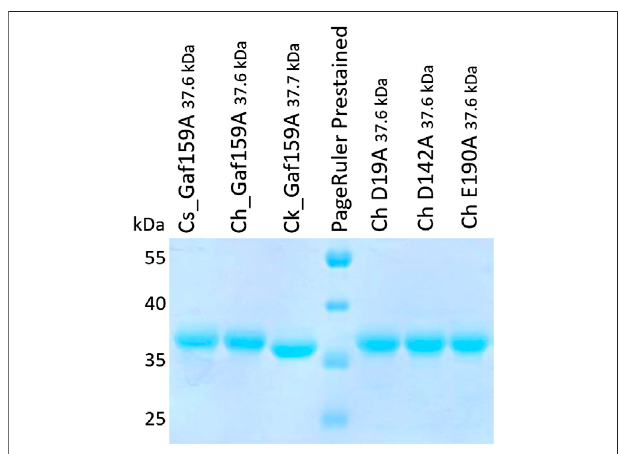
FIGURE 1 | SDS-PAGE analysis of recombinantly produced wildtype and mutant enzymes. Proteinsamples (0.5 µg μ l − 1 ) were mixed with 4x SDS- loading buffer (0.25 M Tris, 40% w/v glycerol, 0.29 M SDS, 0,57 β - mercaptoethanol, 0.02% bromophenol blue, HCl to pH 6.8), 10 µl were loaded into each lane. Size markers were applied as PageRuler ™ Prestained Protein Ladder, 10 – 180